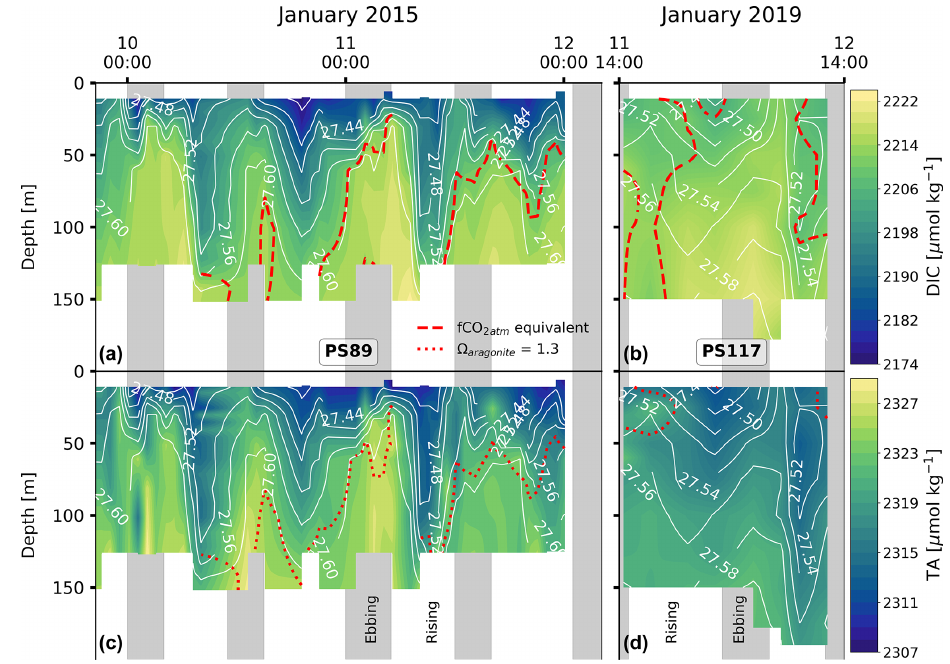
Figure 4. DIC content at the sampling site during the PS89 (a) and PS117 (b) tidal observations. TA content for the PS89 (c) and PS117 (d) observations. White contour lines indicate sigma- t (in kgm − 3 ). Vertical grey-shaded areas indicate periods of ebbing tide, as defined in the text. Dashed red lines in (a) and (b) represent the depth at which the seawater f CO 2 is equal to the atmospheric f CO 2 , which is 377µatm in January 2015 and 387µatm in January 2019. Seawater shallower than this depth is undersaturated in f CO 2 compared to the atmosphere. The dotted red lines in (c) and (d) represent the depth at which (cid:127) ar = 1 . 3. (cid:127) ar is lower at depths below these lines. The value 1.3 is arbitrary to illustrate the vertical variability in the water column. (cid:127) ar ranges between 1.22–1.52 and 1.21–1.34 for PS89 and PS117,